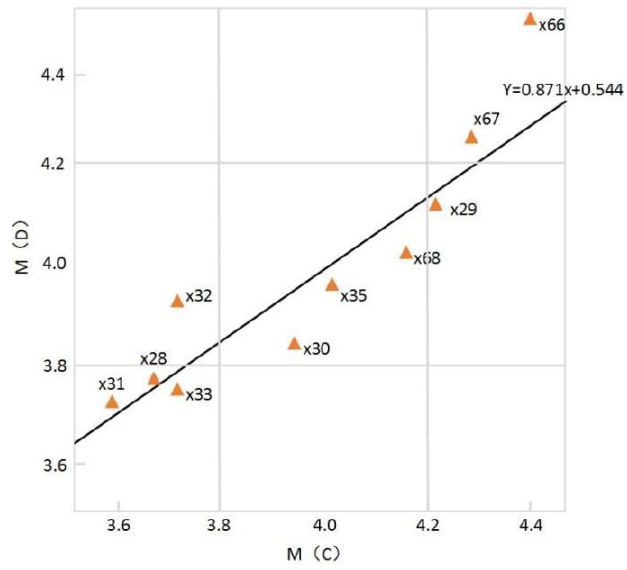
Figure 4. Clusters of economic sustainability indicators.